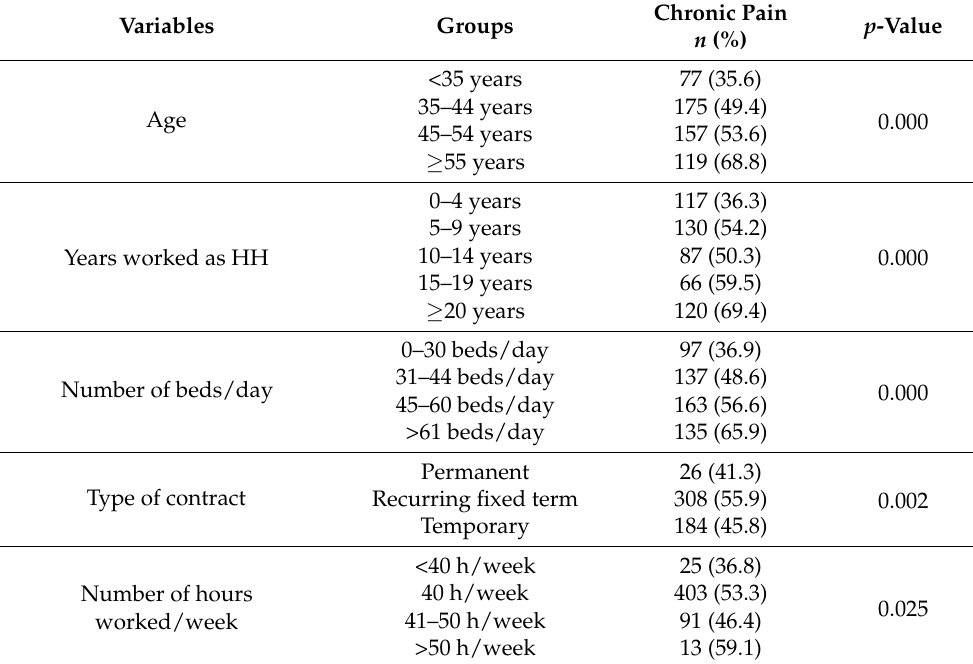
Table 3. Relation between chronic pain and sociodemographic and labour